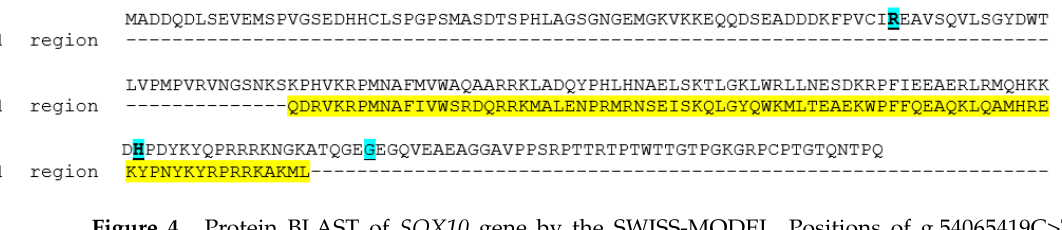
Figure 4. Protein BLAST of SOX10 gene by the SWISS-MODEL. Positions of g.54065419C>T (Arg67Arg), g.54070844C>T (His162His), and g.54070904C>T (Gly182Gly) are highlighted in blue.